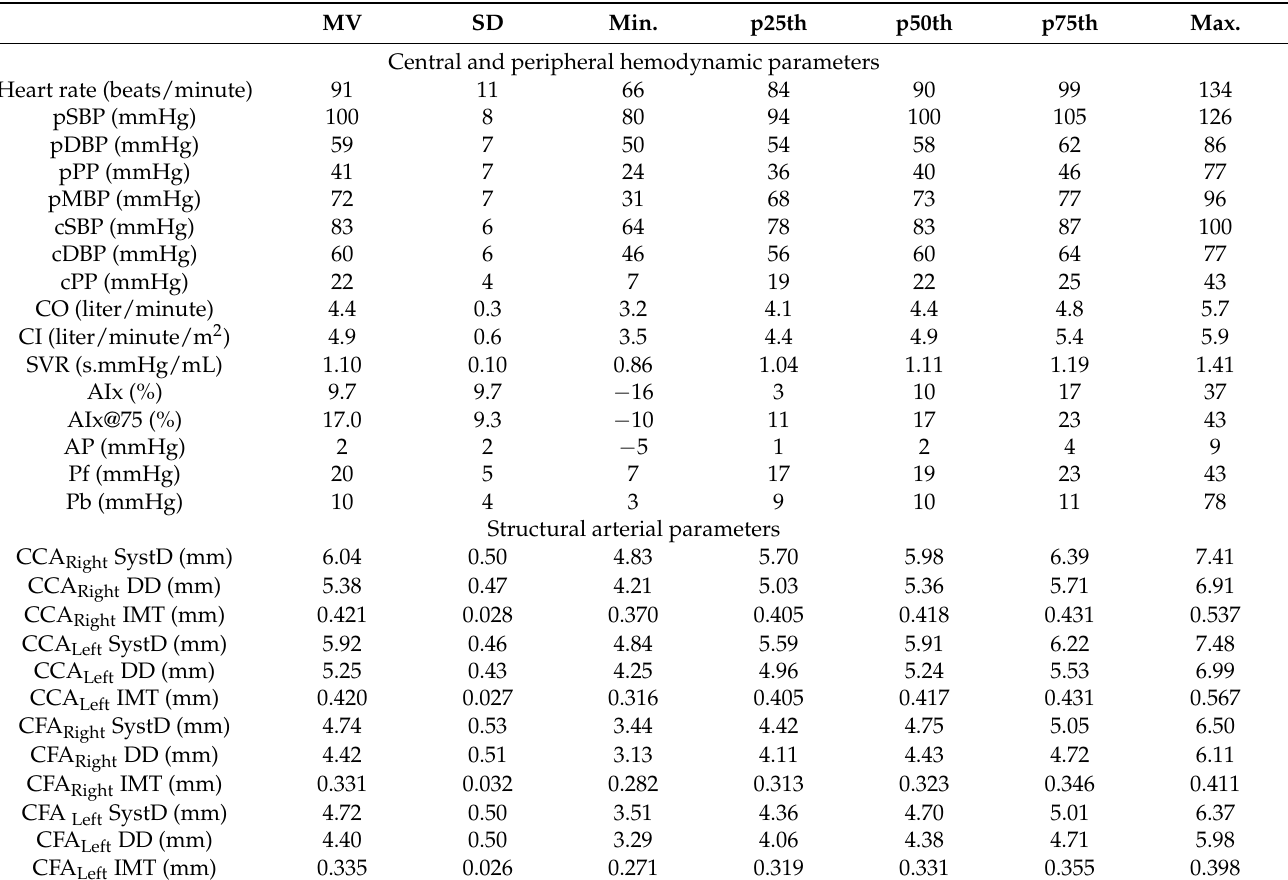
Abbreviations: identical to Table 1. Table 3. Arterial parameters at age 6 years ( n =